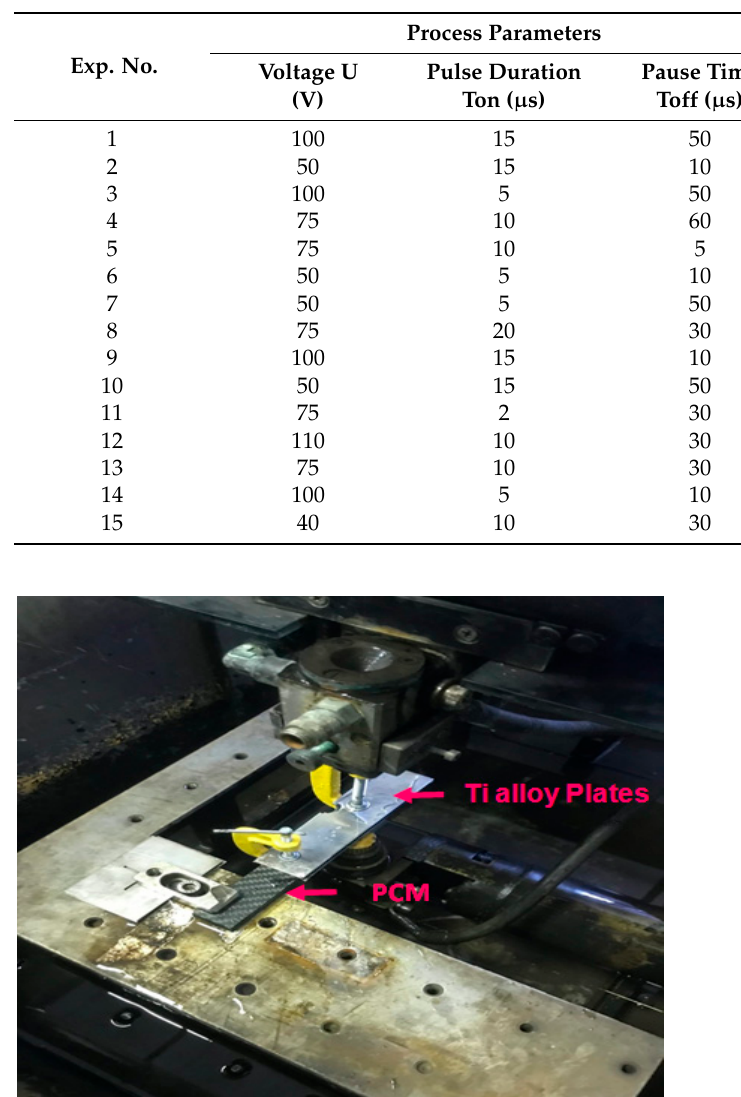
Table 3. Experimental central composition design (CCD) matrix with the responses the experi- ment obtained.